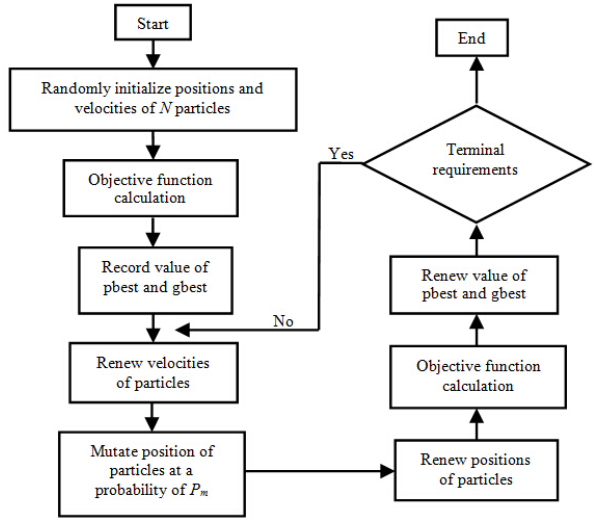
Figure 1. Gaussian mutation particle swarm optimization (GMPSO) algorithm flowchart.